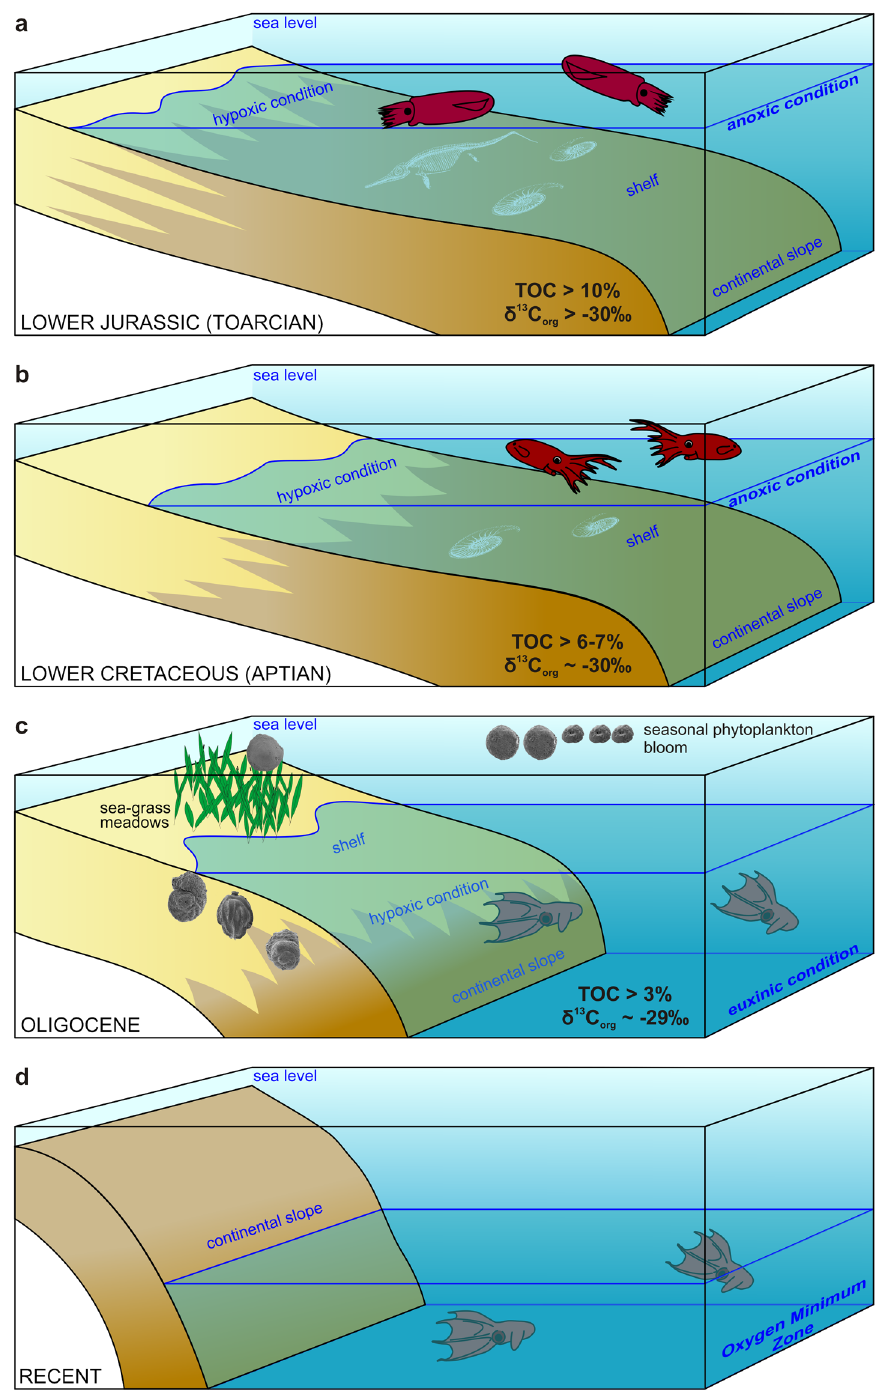
Fig. 8 Onshore – offshore shift of loligosepiid coleoids in relation to bathymetry and the oxygen minimum zone shift from shelf to deep-sea. a Toarcian OAE event with loligosepiid occurrences associated with geographically extensive anoxic conditions on shelves. Geochemical data from ref. 59 . b Aptian OAE1 event with loligosepiids associated with anoxic conditions on shelves. Geochemical data after refs. 66,67 . c Oligocene habitat of N. hungarica in the Central Paratethys. Bathymetric conditions of the gladius record correspond to bathyal habitats with depth >400 m (ref. 39 ). Shallower, shelf environments were characterized by seagrass meadows with seagrass-associated foraminiferal assemblages. Geochemical data — this study and after ref. 37 . d Recent living conditions of V. infernalis adapted to the OMZ at depth >600m (ref. 14 exceptional preservation 64 indicate steep topographic graduents that the total assemblage represents a mixture of bathymetrically distinct habitats 66 , although any postmortem transport had to be over short distances, and it is likely that even a limited short- minor and rapid as indicated by the excellent preservation of distance migration to soft-bottom habitats in the wake of anoxic events or postmortem transport can explain the mixture of groups differing in ecological requirements in deeper environments. To